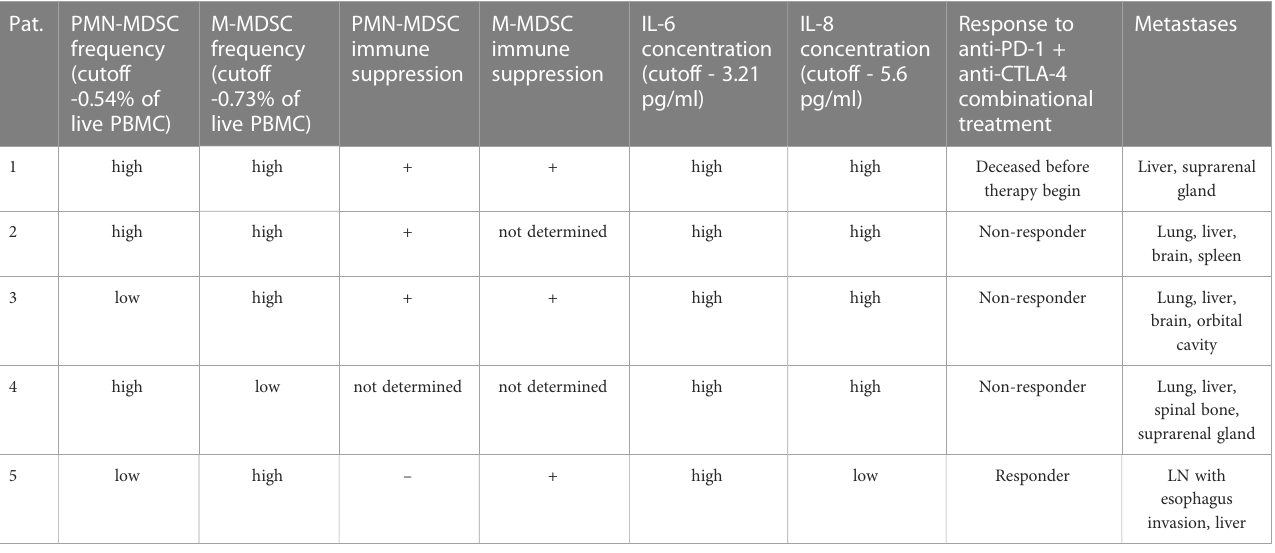
TABLE 2 Baseline MDSC and cytokine levels in patients with metastatic melanoma who received combinational anti-PD-1 and anti-CTLA-4 treatment. Pat.